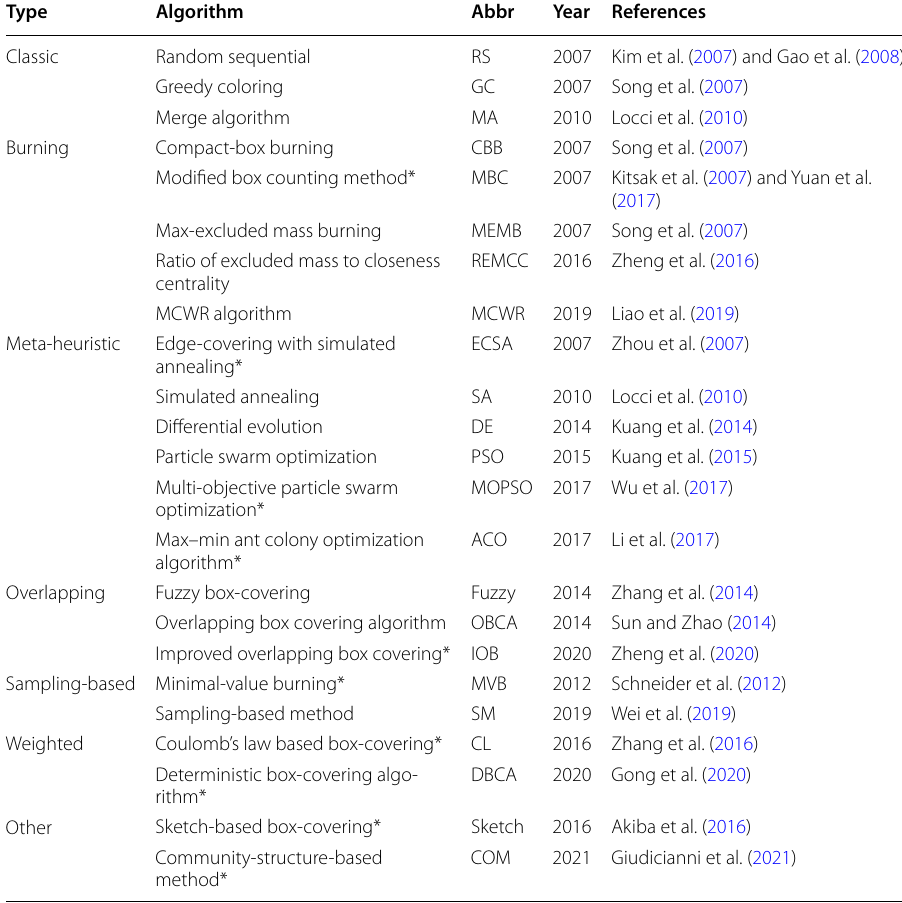
The starred algorithms are not yet available in our